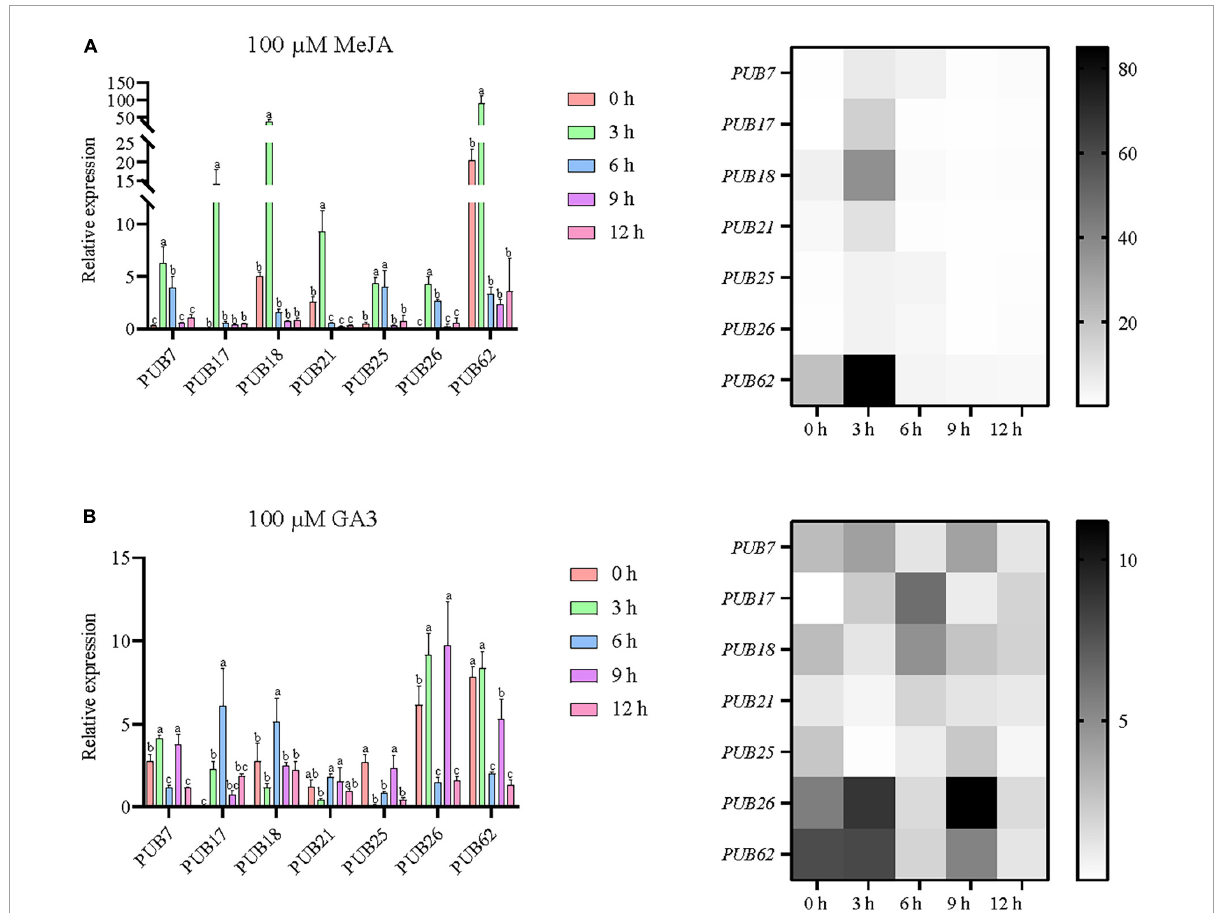
FIGURE10 Potential responses of the seven sorghum U-box genes to methyl jasmonate (A) and gibberellin (B) . All seven selected sorghum PUB genes ( SbPUB7 , SbPUB17 , SbPUB18 , SbPUB21 , SbPUB25 , SbPUB26 , and SbPUB62 ) show obvious expression differences under different conditions in heatmaps, and contain numerous JA/GA3 response elements. Different lowercase letters indicate a significant difference determined by the Duncans new multiple range test ( P -value <